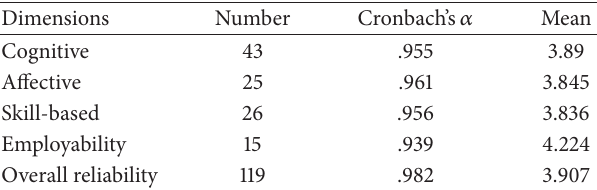
Table 4: Reliability analysis—universities sample. Table 5: Reliability analysis—industry